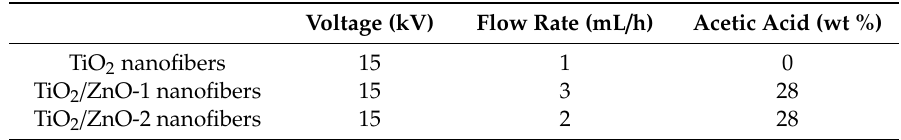
Table 2. Electrospinning process conditions of nanofibers used in the decomposition of methylene blue for photocatalytic performance evaluation.